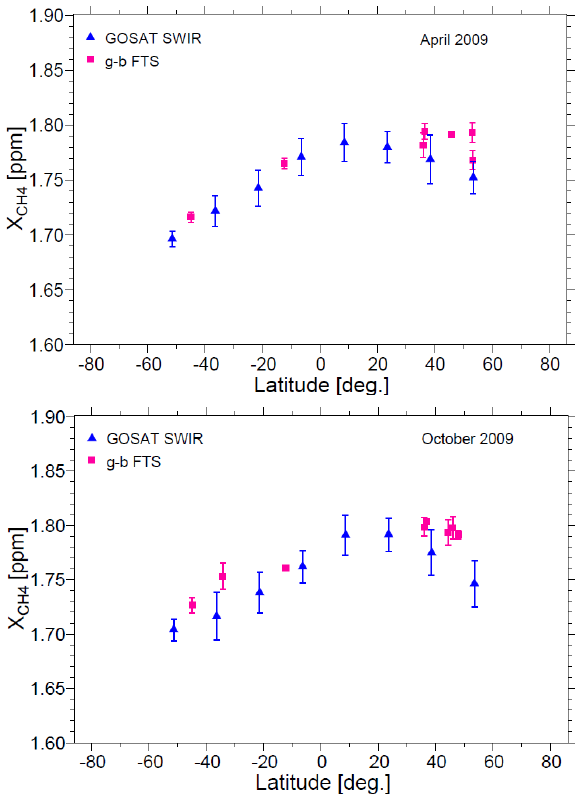
Fig. 9. As Fig. 8 but for X CH 4